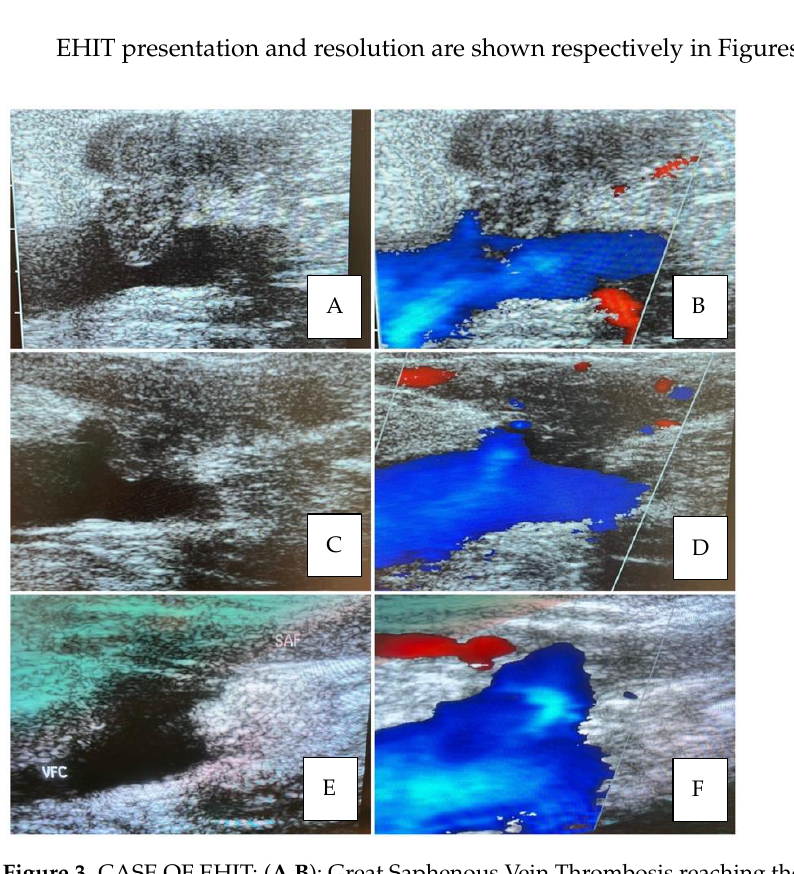
Figure 3. CASE OF EHIT: ( A , B ): Great Saphenous Vein Thrombosis reaching the Sapheno-Femoral Junction and projecting in the Common Femoral Vein. This is one case of the nine EHIT occurring after Radiofrequency treatment. ( C , D ): Partial Regression Of The Thrombosis After 7 Days And Initial Restored Patency Of The Epigastric Vein. ( E , F ): Complete Regression Of The Thrombus And Complete Restored Patency Of The Epigastric Vein.